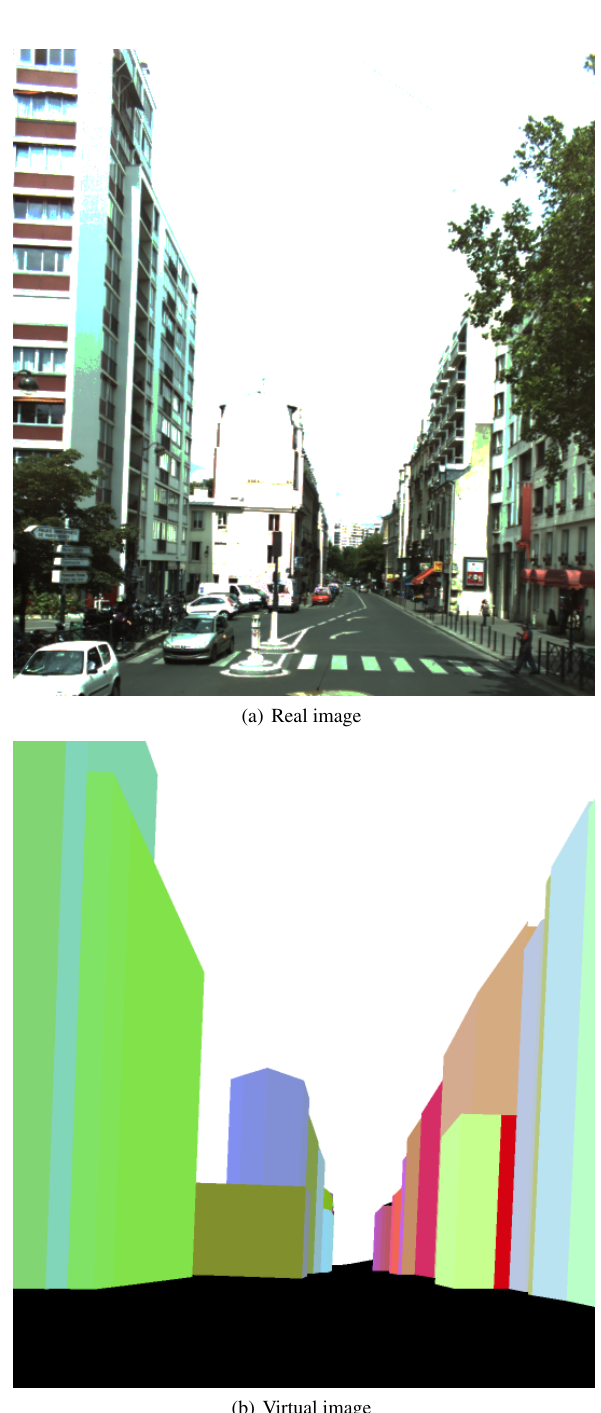
Figure 1: A real image and superposable virtual image obtained by capturing the 3D model from the same point of